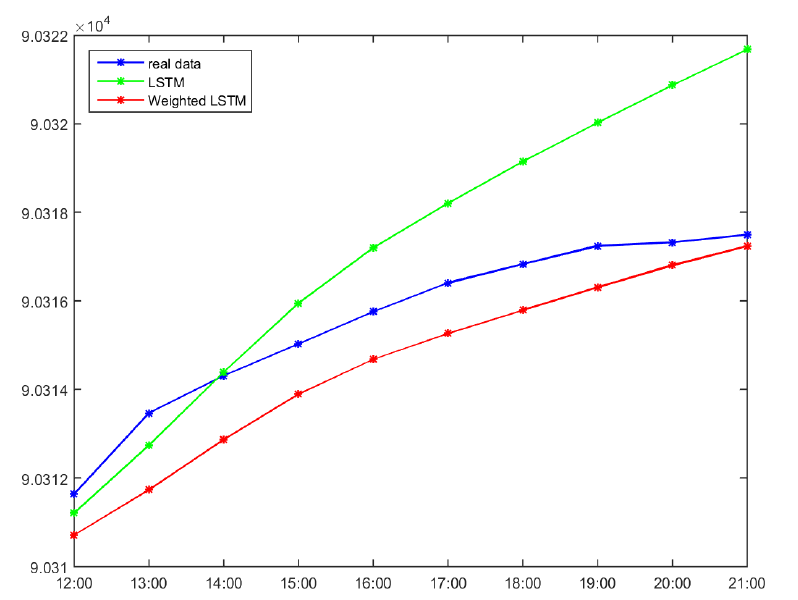
Figure 18. Comparison among the LSTM estimate and weight-applied compensation, LSTM estimation-based compensation, and real